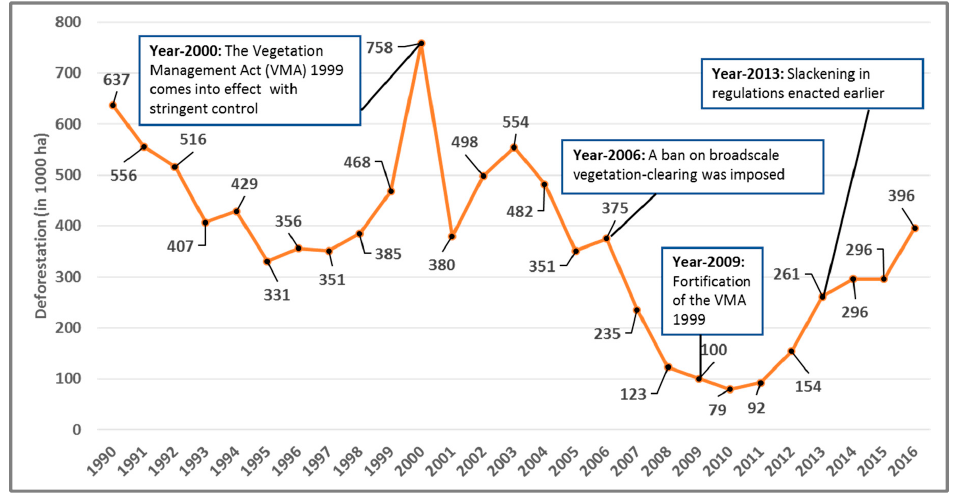
Figure 8. Queensland’s deforestation between 1990 and 2016, derived from the Wilderness Society, [57] and Steffen & Dean [32].